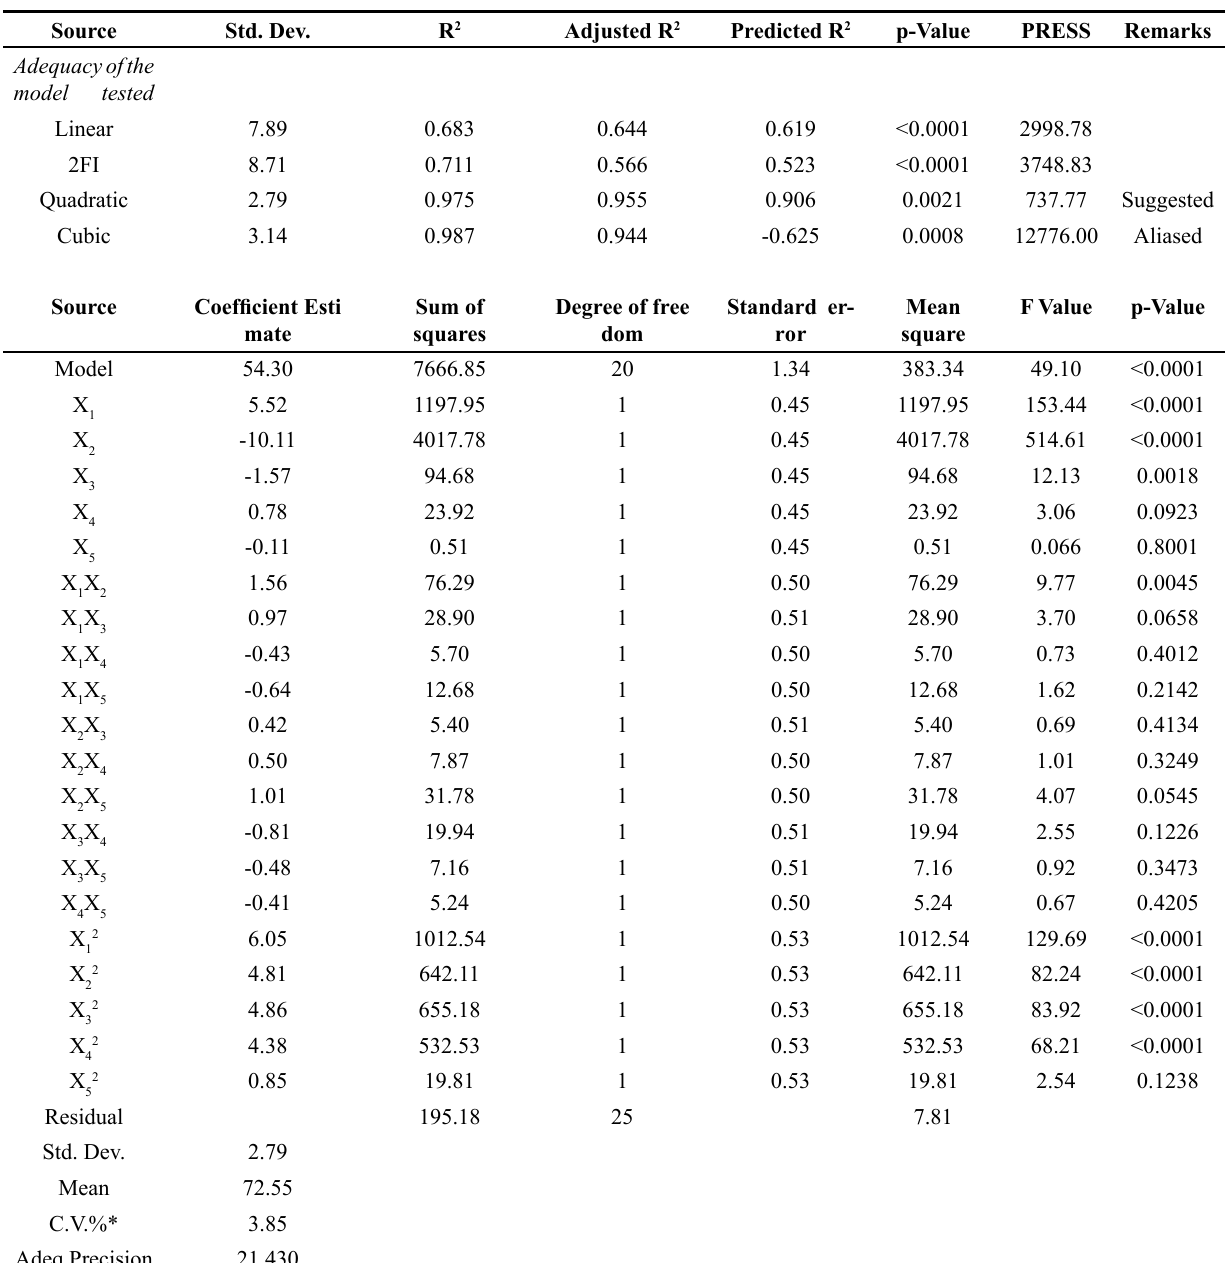
ANOVA analysis for the percentage of pyrite sulphur removal from bitumen.